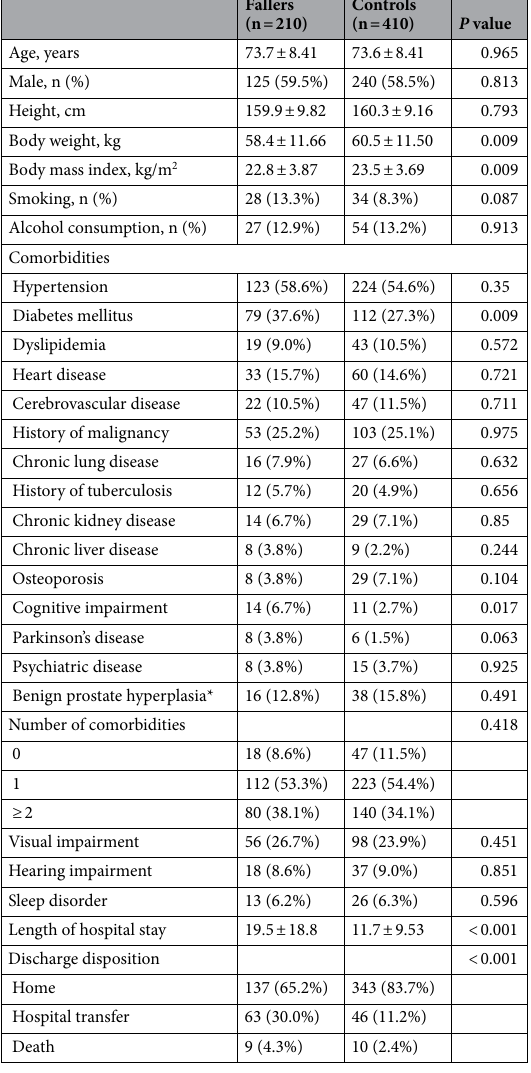
Table 1. General characteristics of fallers and matched controls. Data are presented as means (standard deviation) or frequencies (percentage), as appropriate. *The prevalence of benign prostate hyperplasia was calculated in male